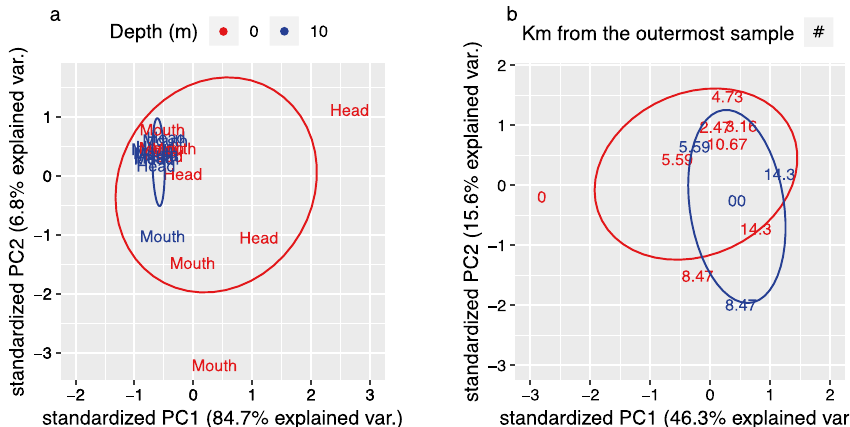
Figure 1. Comparison of Biolog Ecoplates results for surface vs. 10m samples by principal component analysis (PCA). Surface and 10m samples compared across 5 sites. ( a ) Comparison of samples from a transect in a single site (Long Sound). ( b ) Text labels represent horizontal sample location (head/mouth of the fjord [ a ], or Km from the outermost sample [ b ]). Ellipses represent the 95% confidence